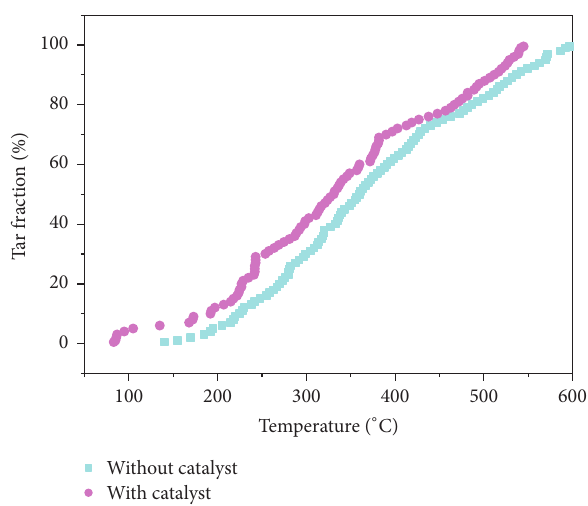
Figure 6: Tar fraction as a function of simulated distillation temperature without and with catalyst.